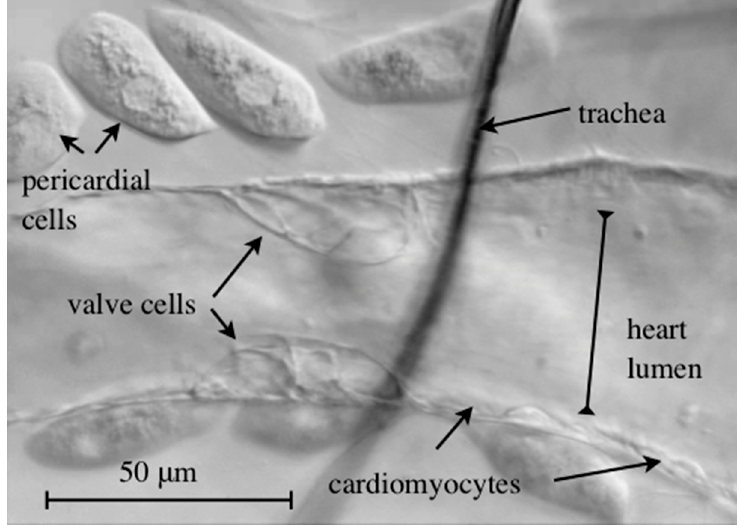
Figure 4. Brightfield microscopy image of a semi-intact wild-type third instar larval heart. The Drosophila heart harbors two specialized valve cells that regulate blood flow directionality.